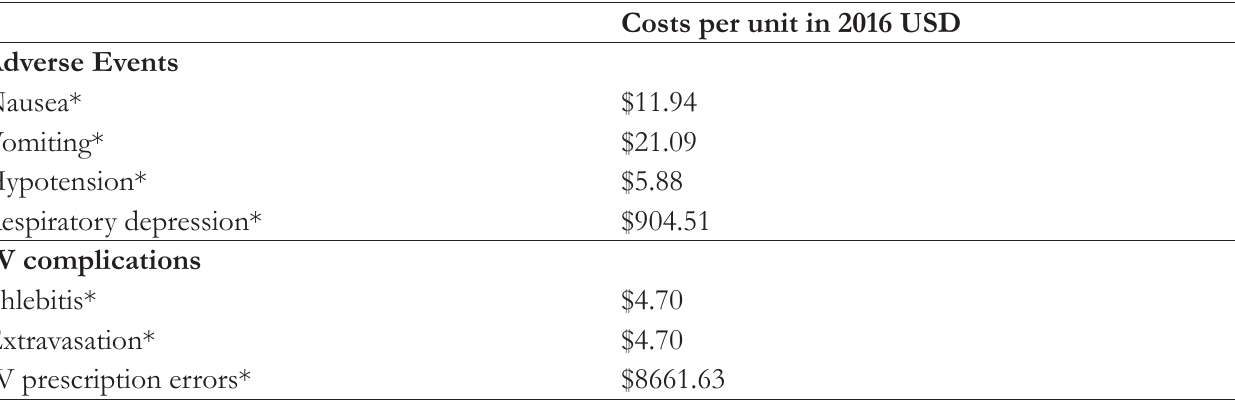
Table 7. Summary of Costs to Manage each AE and IV Complication in US Emergency Departments